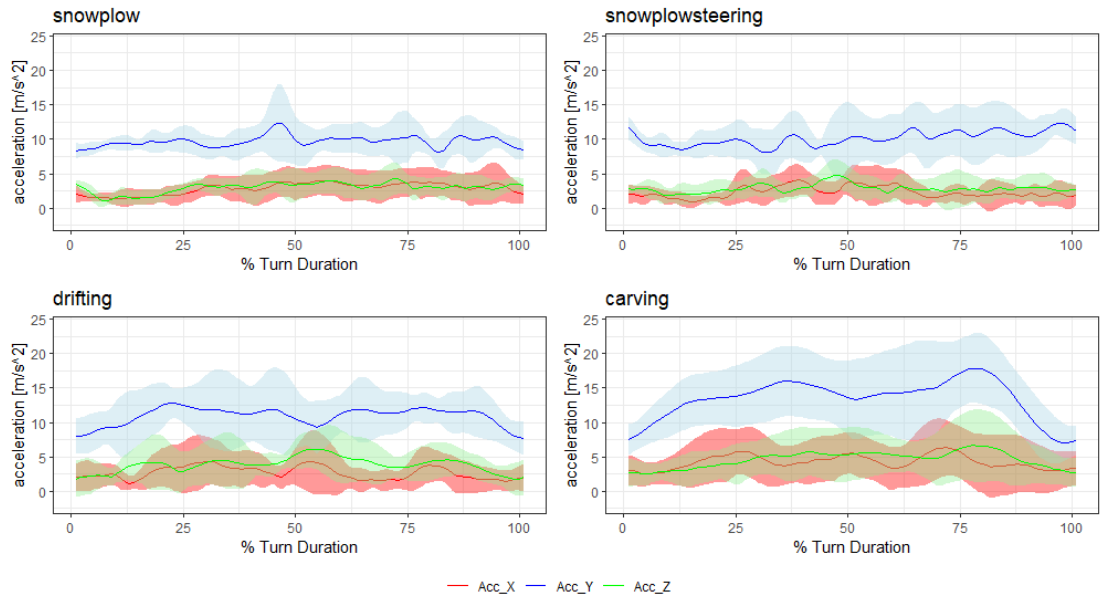
Figure 2. Accelerometer data for each style.